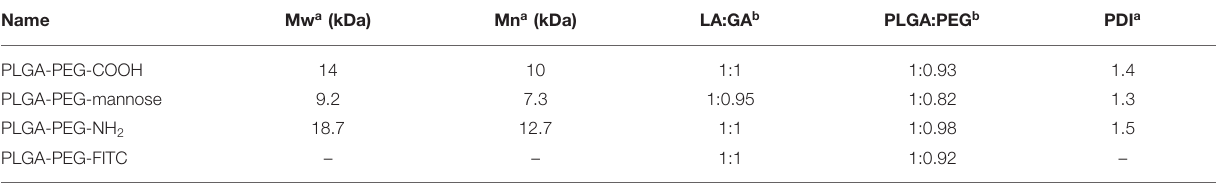
TABLE 1 | Mn, Mw, and PDI of PLGA-PEG and PLGA-PEG-mannose copolymers.